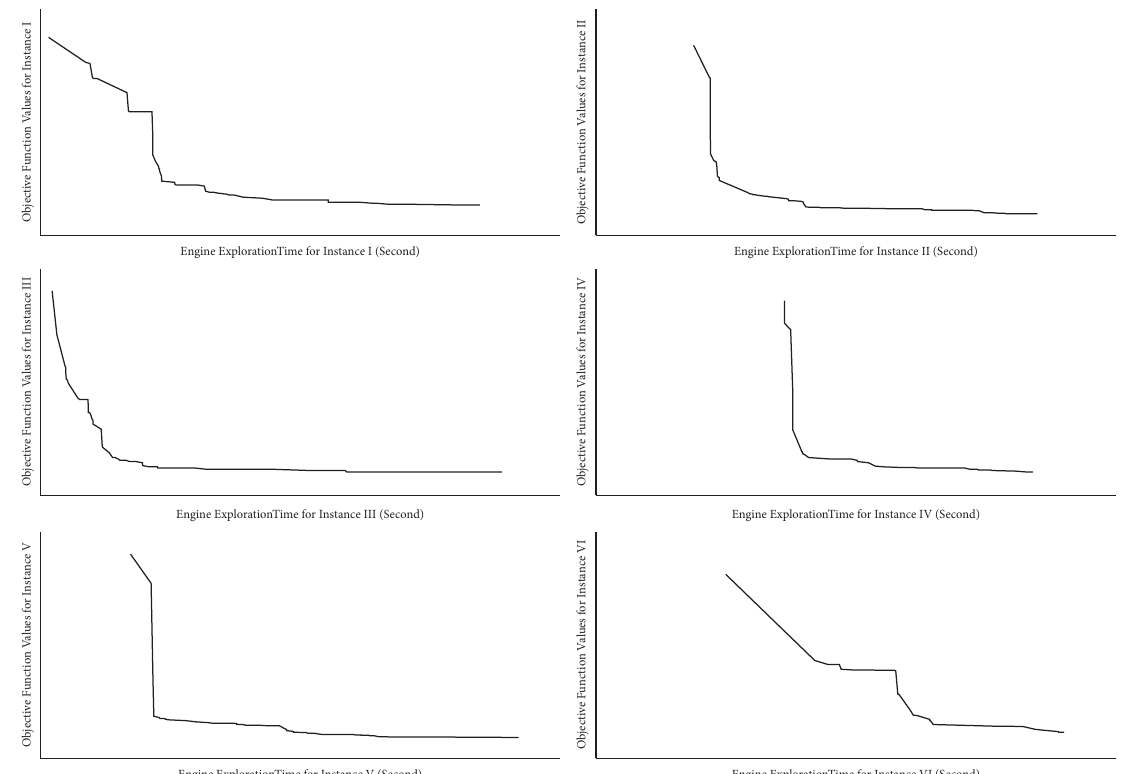
Figure 5: The convergence condition when CPLEX solves each